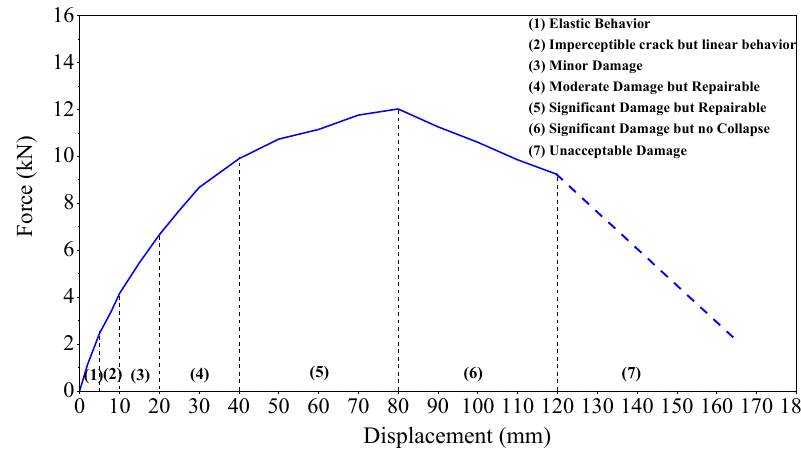
Figure 19. Typical force-displacement curve of a pile with its failure process.